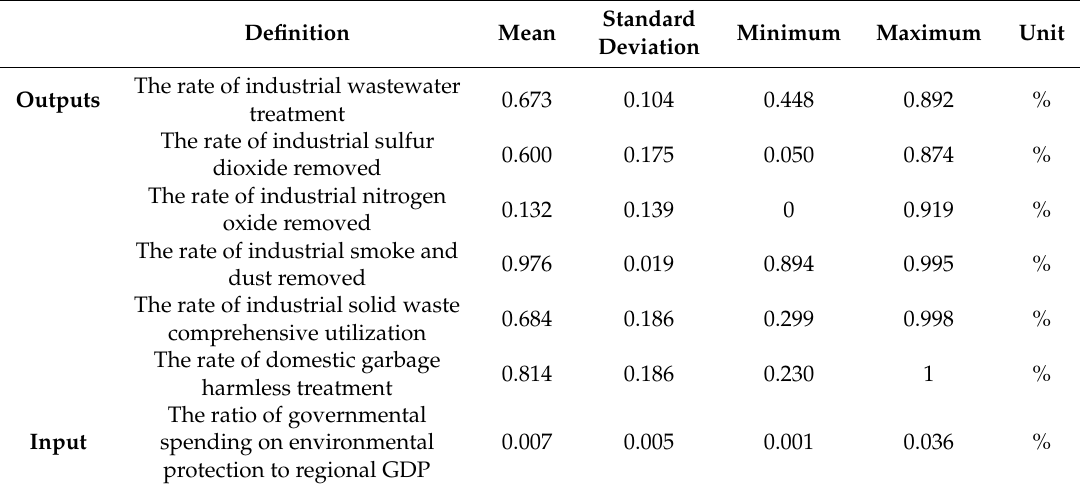
Table 1. Input–output factor definitions and descriptive